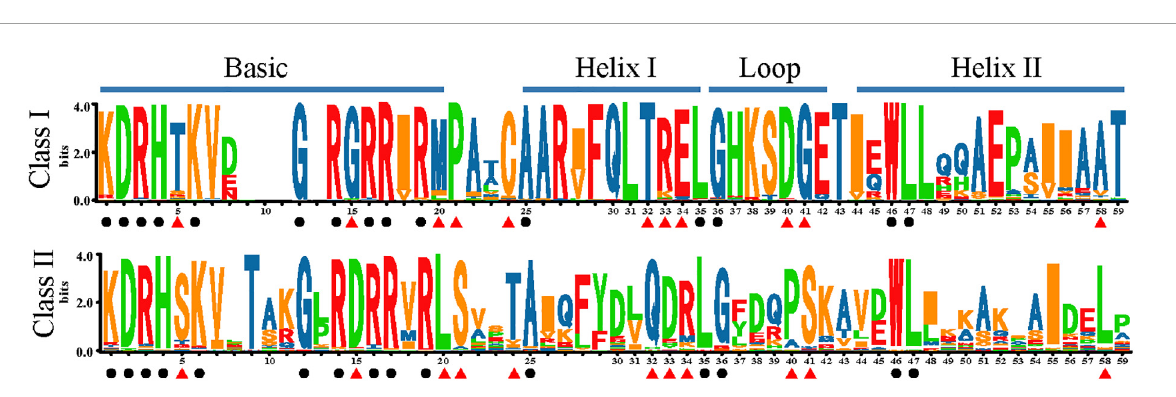
FIGURE4 Sequence logos of the plant TCP domains. Bit scores represents the relative frequency of amino acids. The black circle represents conserved loci within the whole family. The red triangle indicates divergent but conserved residues in each subclade.